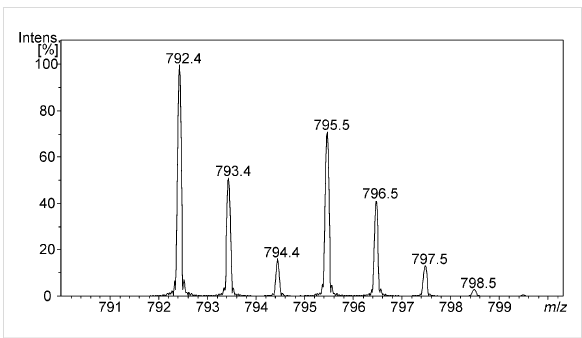
Figure 5: ESI-mass spectrum (positive mode) of a 1:1:1 mixture of 1 , protonated L-leucine methyl ester (LeuOMe), and protonated L-leucine trideuteromethyl ester (LeuOMe- d 3 ) in a 1:1 mixture of CH 2 Cl 2 /MeOH ( m / z = 792.4 LeuOMe– 1 , m / z = 795.5 LeuOMe- d 3 – 1 ).